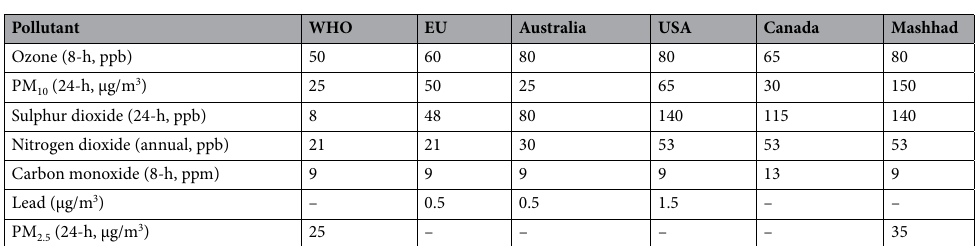
Table 2. Standard levels of air pollutants given by American (USA), Australian, the European Union (EU), and the World Health Organization (WHO) including the permitted in Mashhad (Iran). μg/m 3 micrograms per cubic meter, ppb part per billion, ppm part per